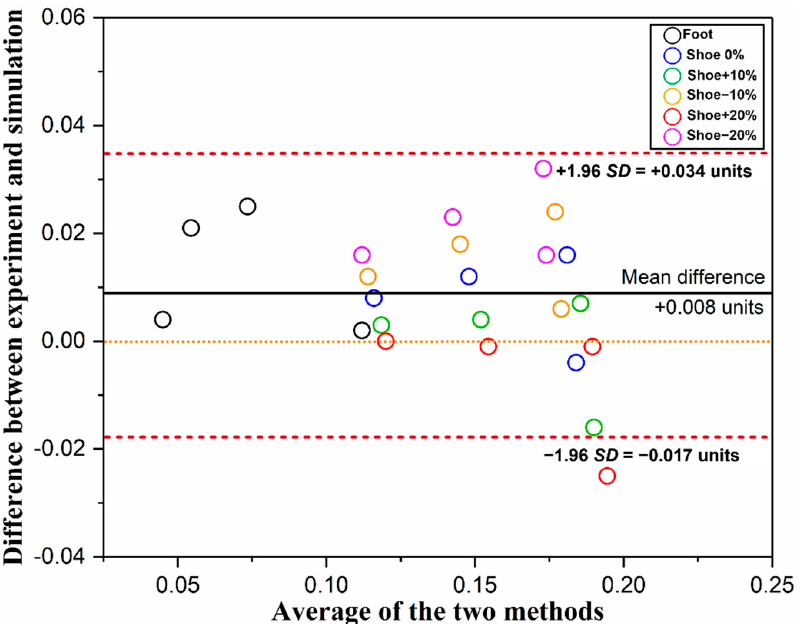
Figure 4. Bland–Altman plot of experimental and simulated pressure data. Different colored circles represent different regions. As shown in the figure legend, the black one represents the plantar regions, while the other five represent the sole regions with different material properties.